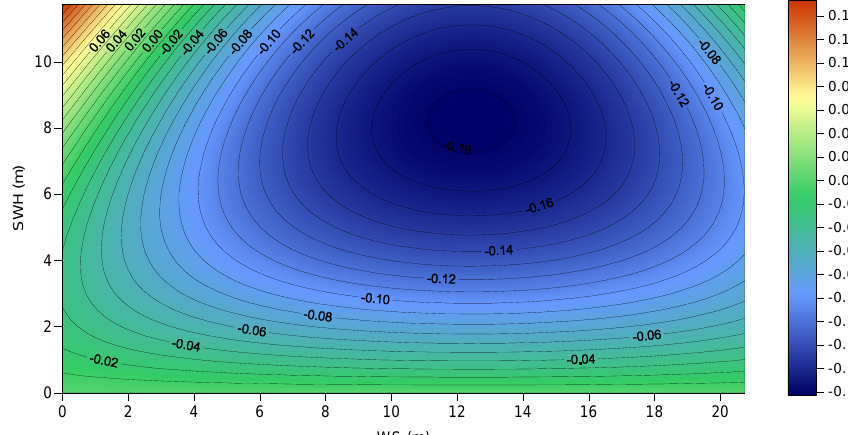
Figure 11a – Chambers SSB model for TOPEX A (metres).